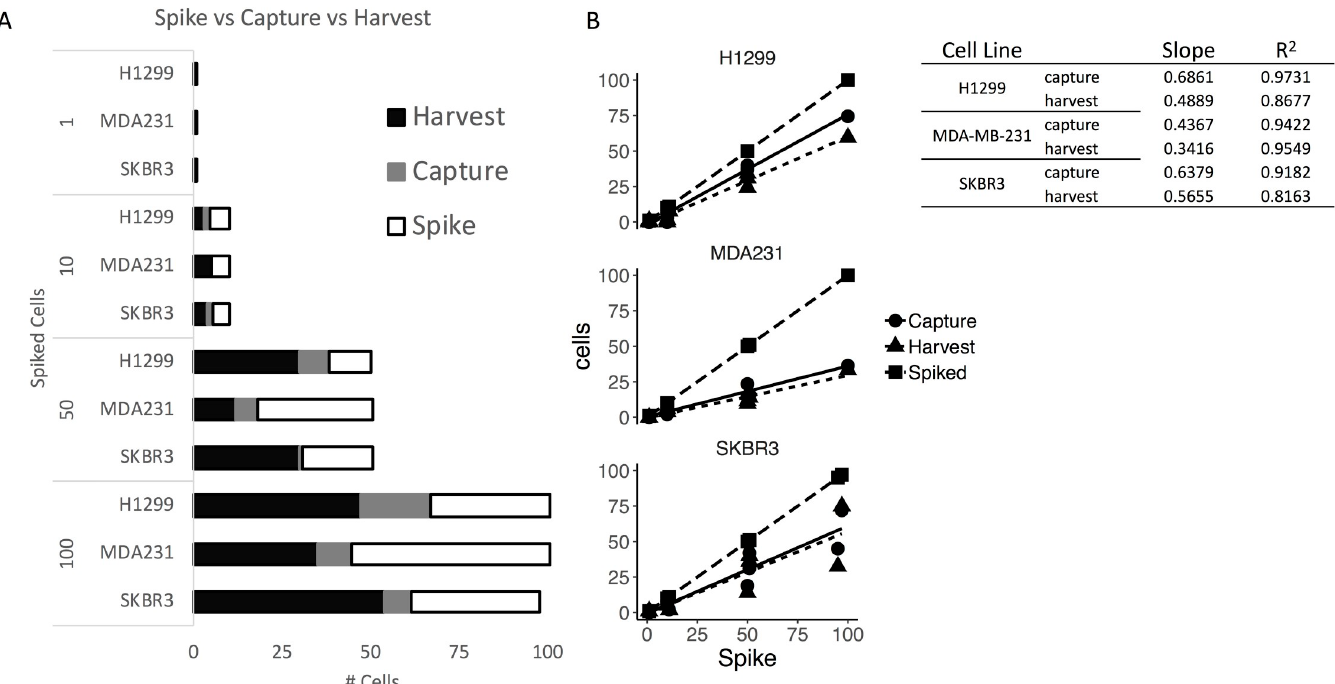
Fig 1. Capture and harvest efficiency and linearity of Parsortix PR1 by imaging. A): The mean total number of cells spiked (white), captured (gray), and harvested (black) from healthy donor blood (n = 3 normal donors). B): Scatter plots with linear regressions performed on the triplicate data. Each graph shows a linear regression for the total number of cells (square), the number captured (circle), and the number harvested (triangle). These plots show the linearity of the data.